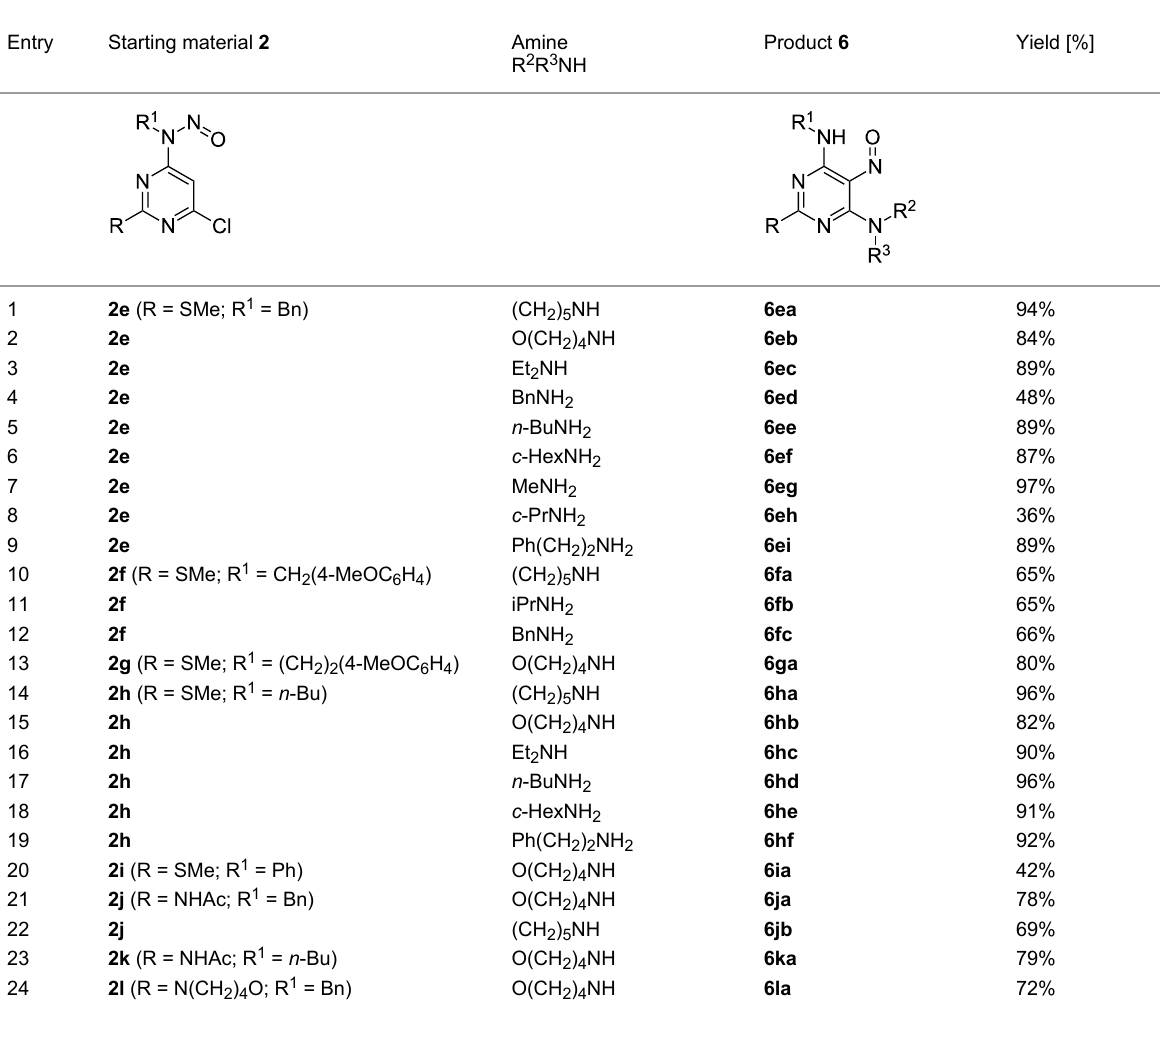
Table 2: Data on the one-pot nucleophilic substitution/nitroso group transfer reactions in 6-chloro- N -disubstituted- N -nitrosopyrimidin-4-amines.